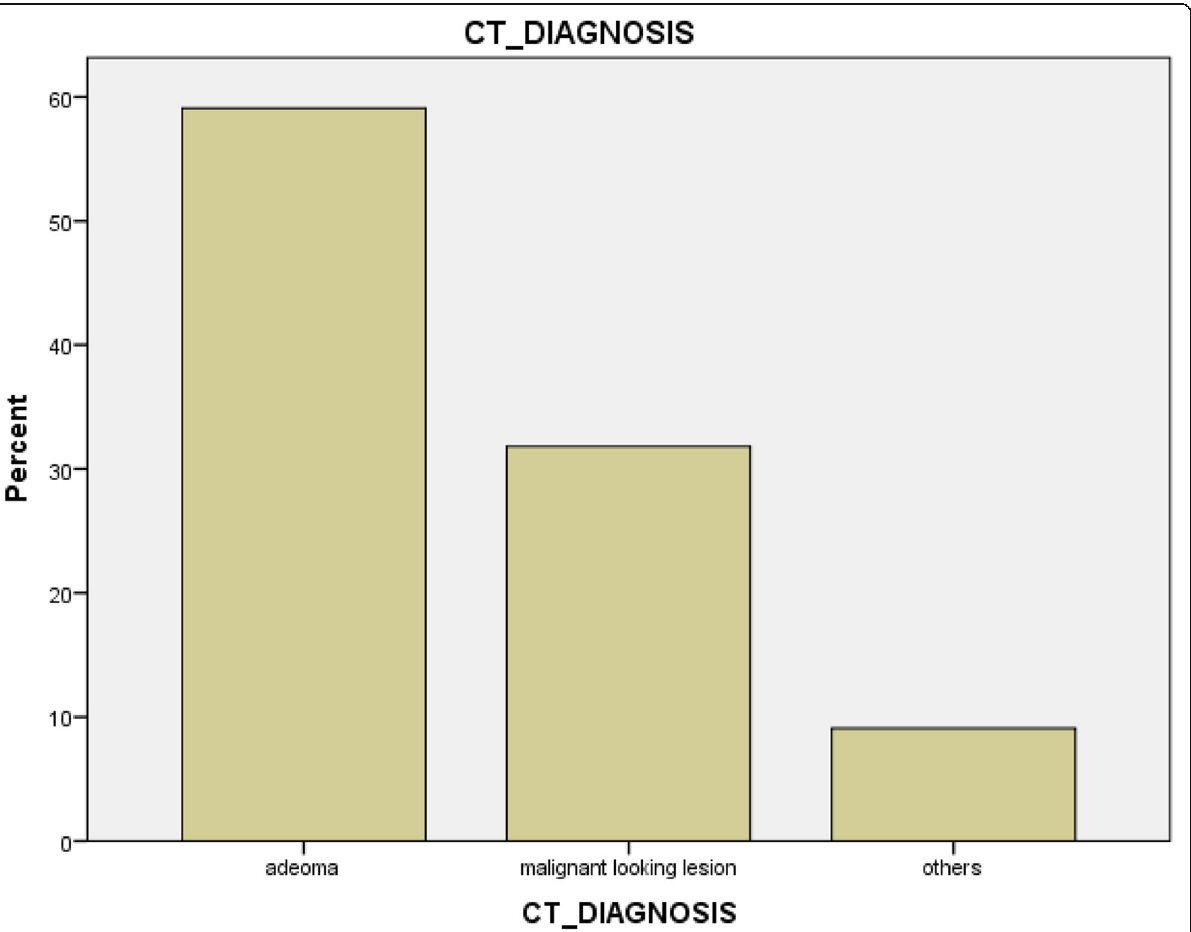
Fig. 1 CT radiological diagnosis of adrenal lesions in the study population